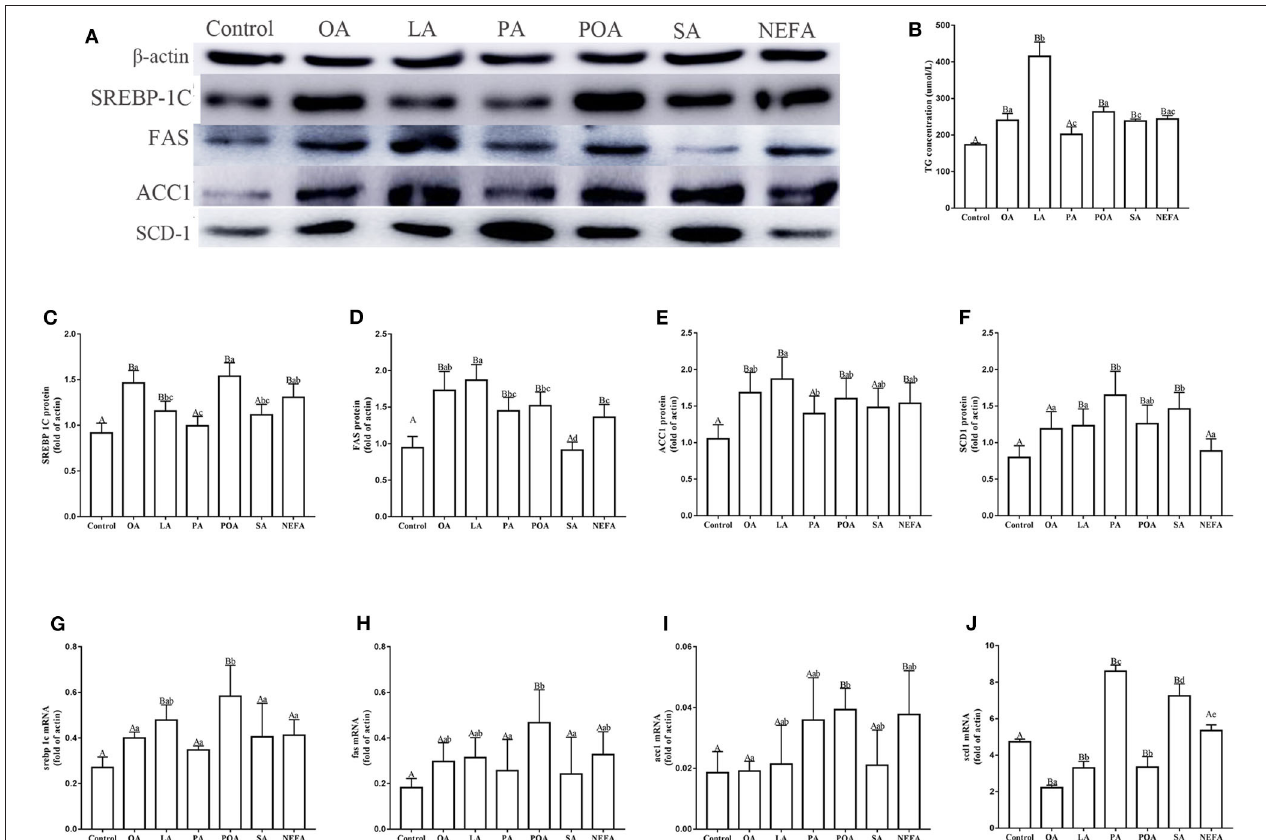
FIGURE 2 | Effects of fatty acids on fat synthesis. Cells were treated with 1.2 m M fatty acids for 12h ( n = 3 ell preparations). (A) β -actin, SREBP-1c, FAS, ACC1, and SCD1 protein expression were assayed by western blotting. Gray-shaded bars represent the amount (%) of β -actin, SREBP-1c, FAS, ACC1, and SCD1 in